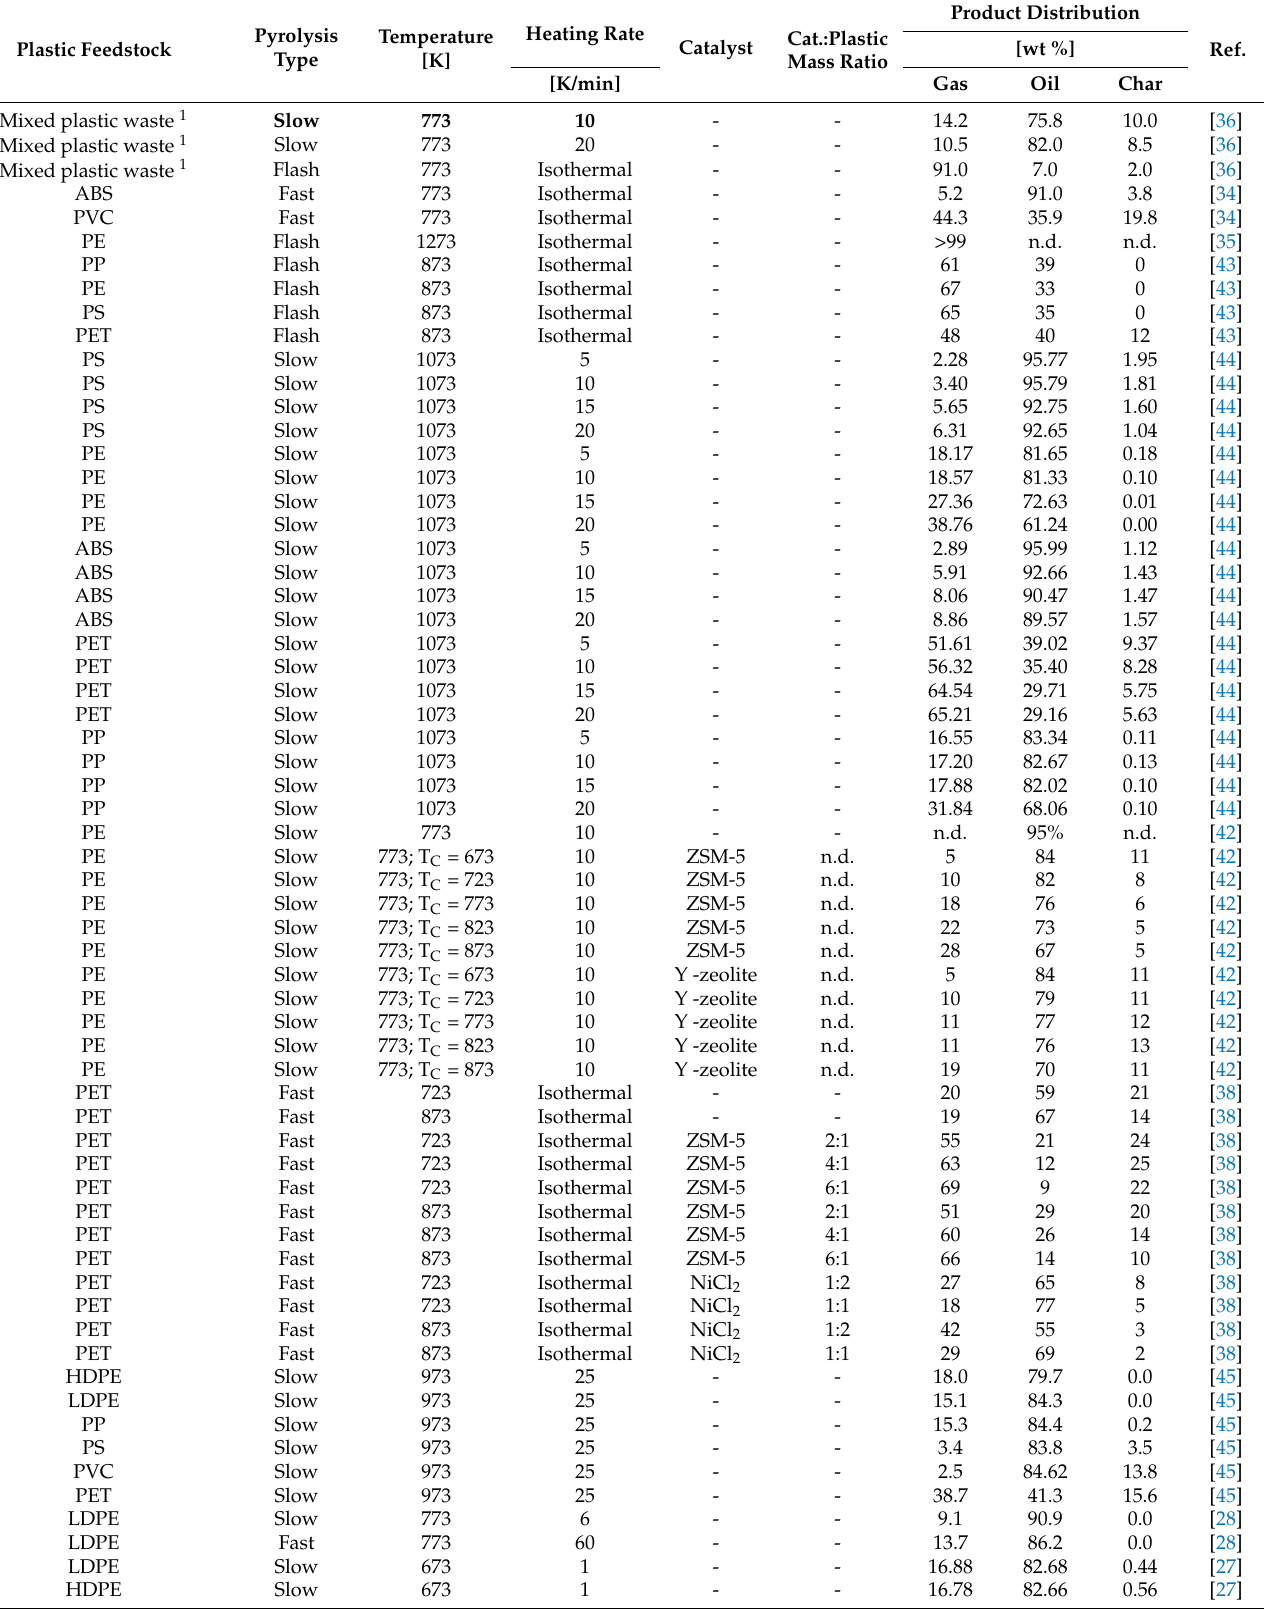
Table 2. Selected process parameters of the pyrolysis of plastics and obtained product